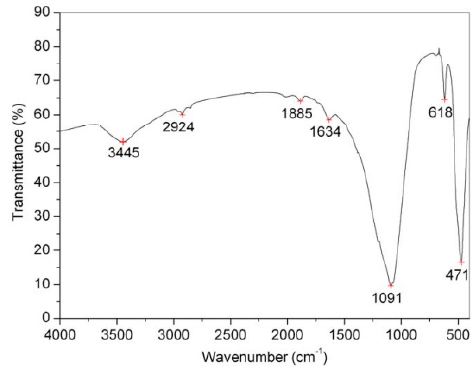
Figure 1. Fourier-transform infrared spectroscopy (FTIR) spectrum of diatomite.